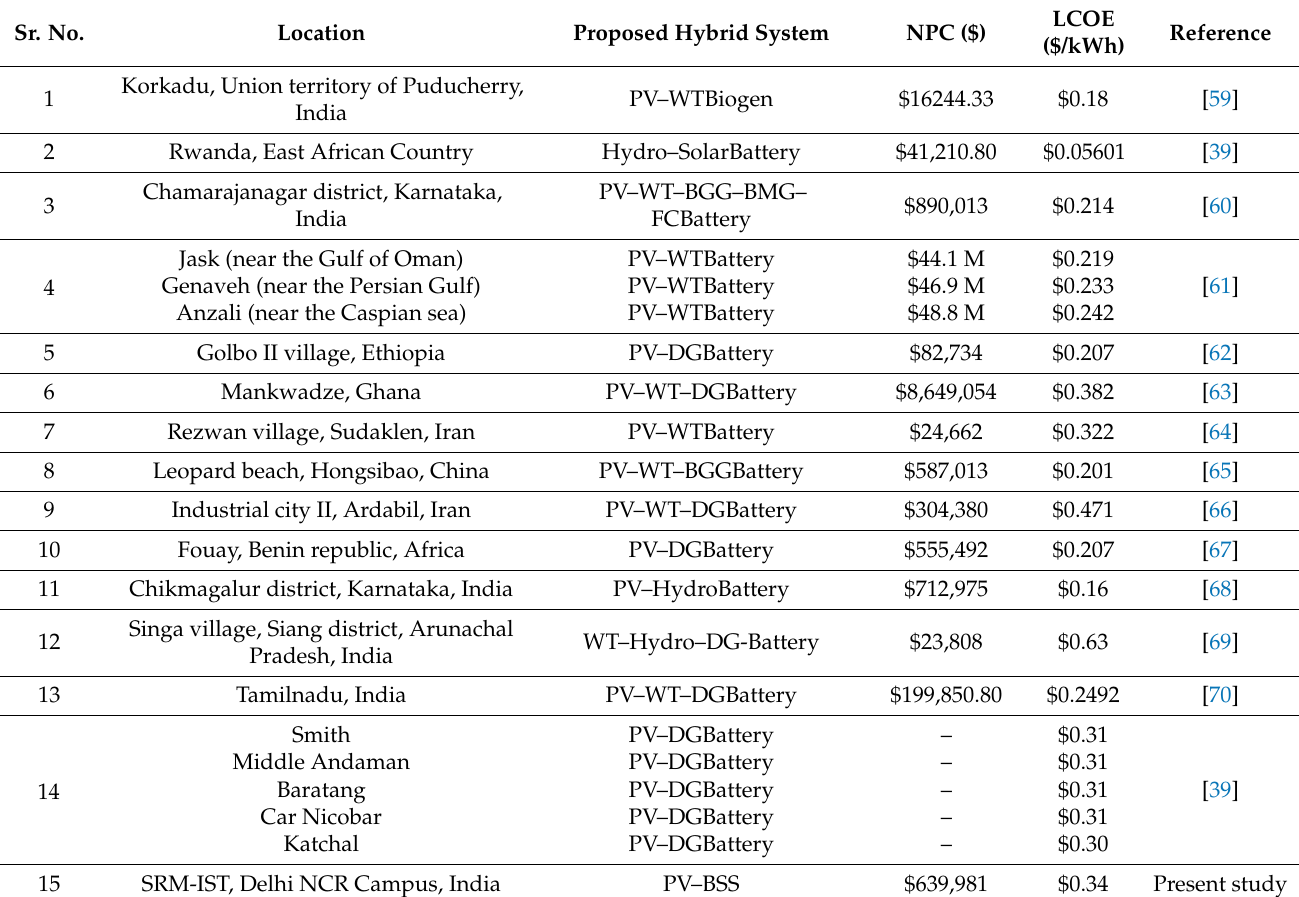
Table 14. Comparison of off-grid hybrid systems at different locations. Sr.